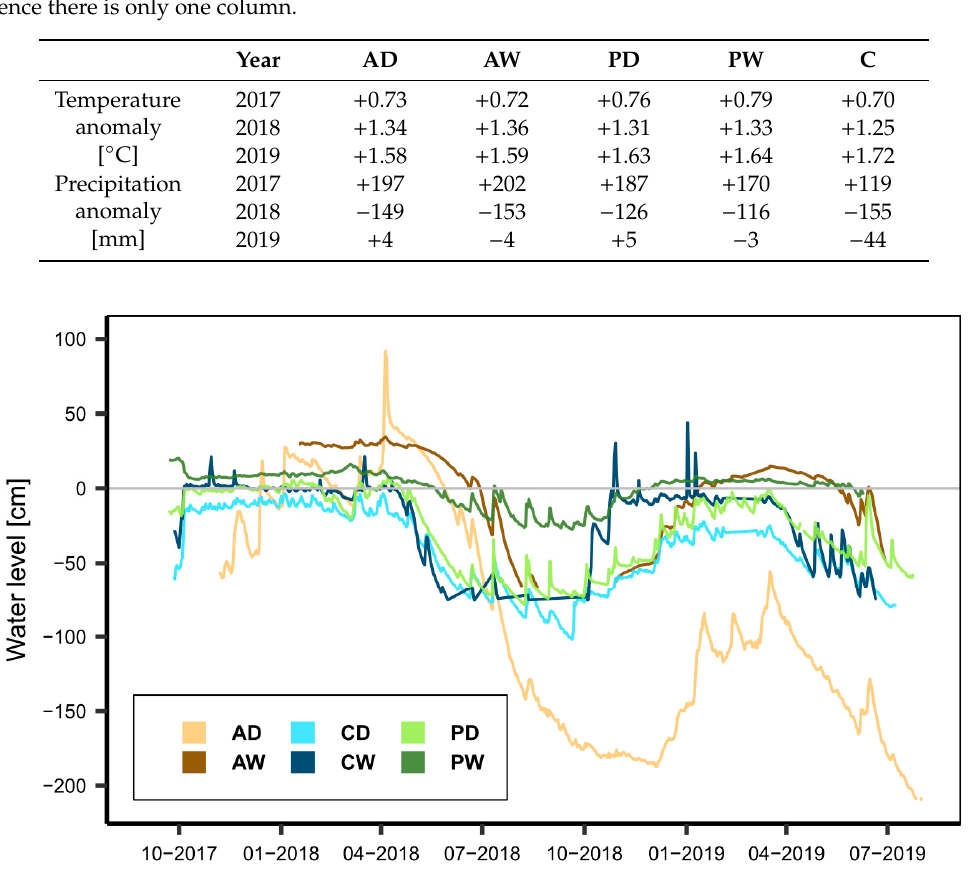
Figure 5. Course of water levels in the study sites over the study period. Water levels are given relative to ground surface and were measured with SEBA Dipper PT (SEBA Hydrometrie) or CS457 connected to CS1000 datalogger (Campbell Scientific; the latter in the alder forest